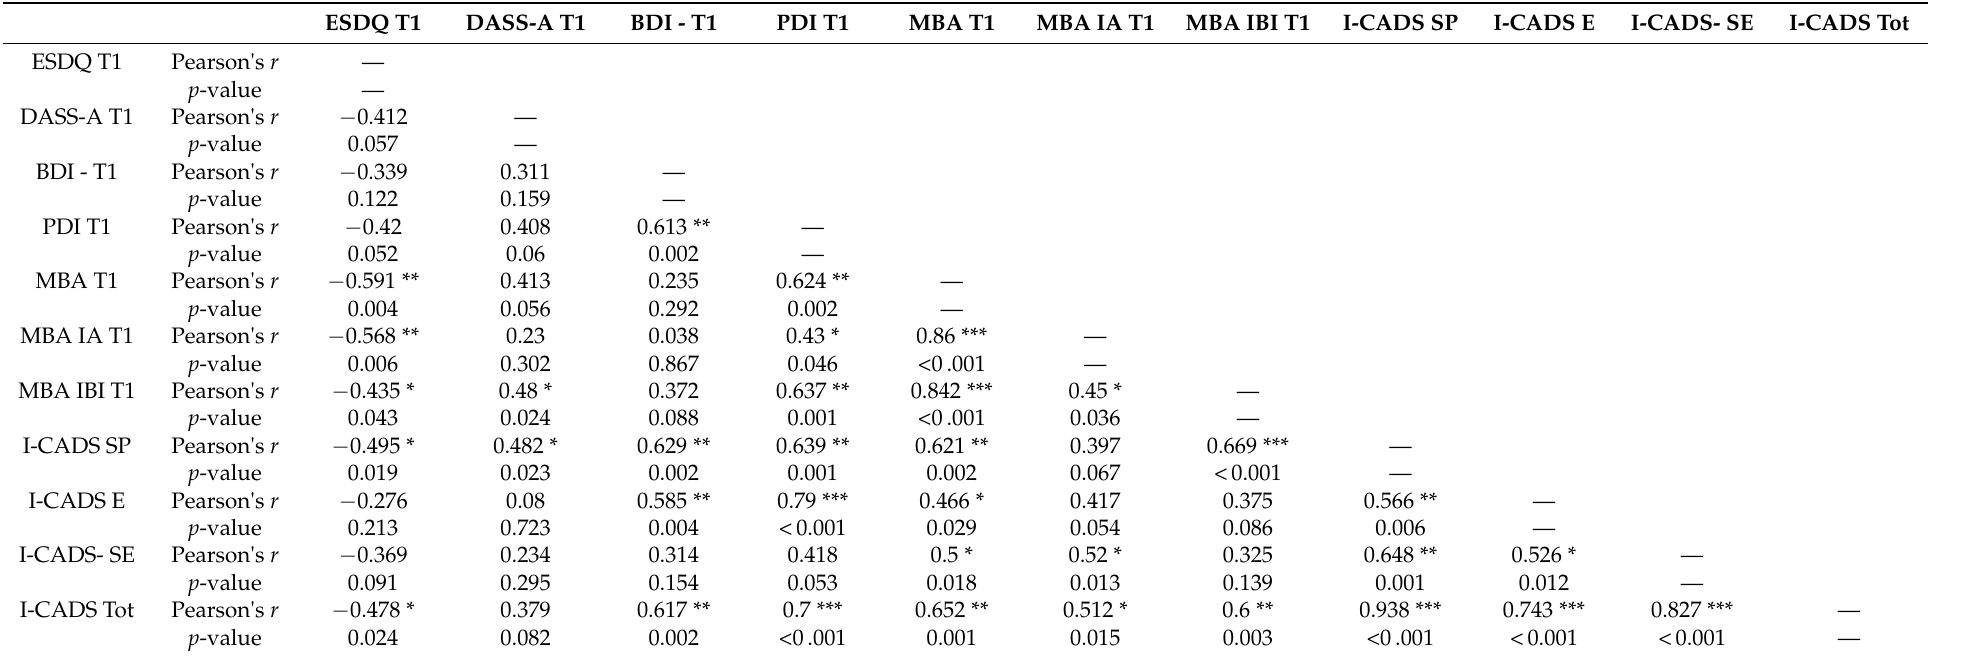
Table 6. Correlation Matrix (Pearson’s r ) of emotional dimensions of sample at